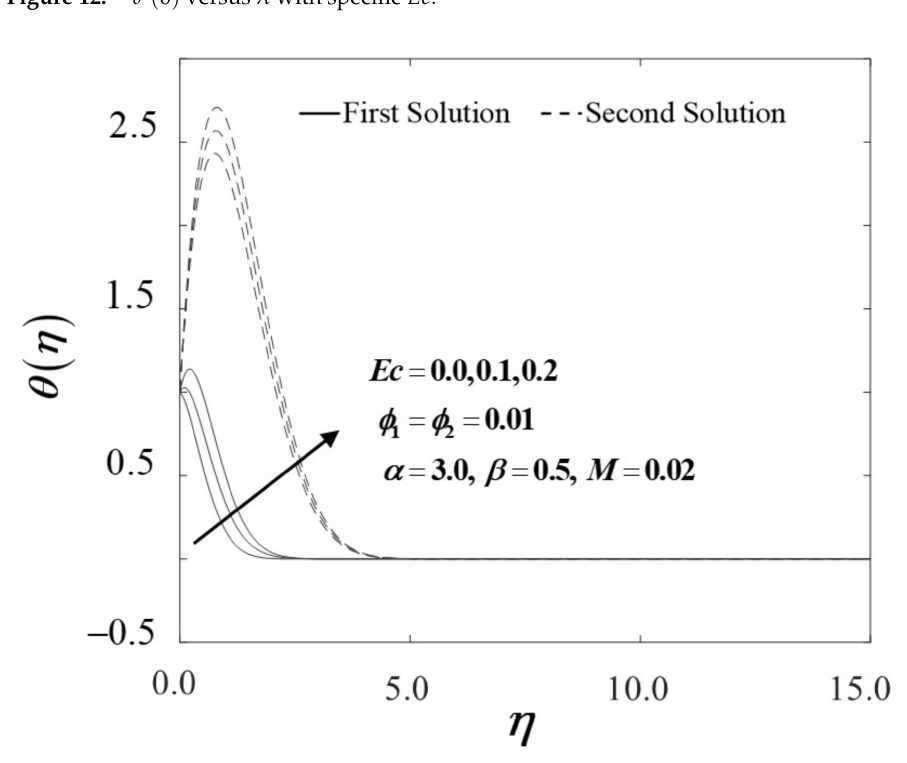
Figure 13. θ ( η ) versus η with specific Ec